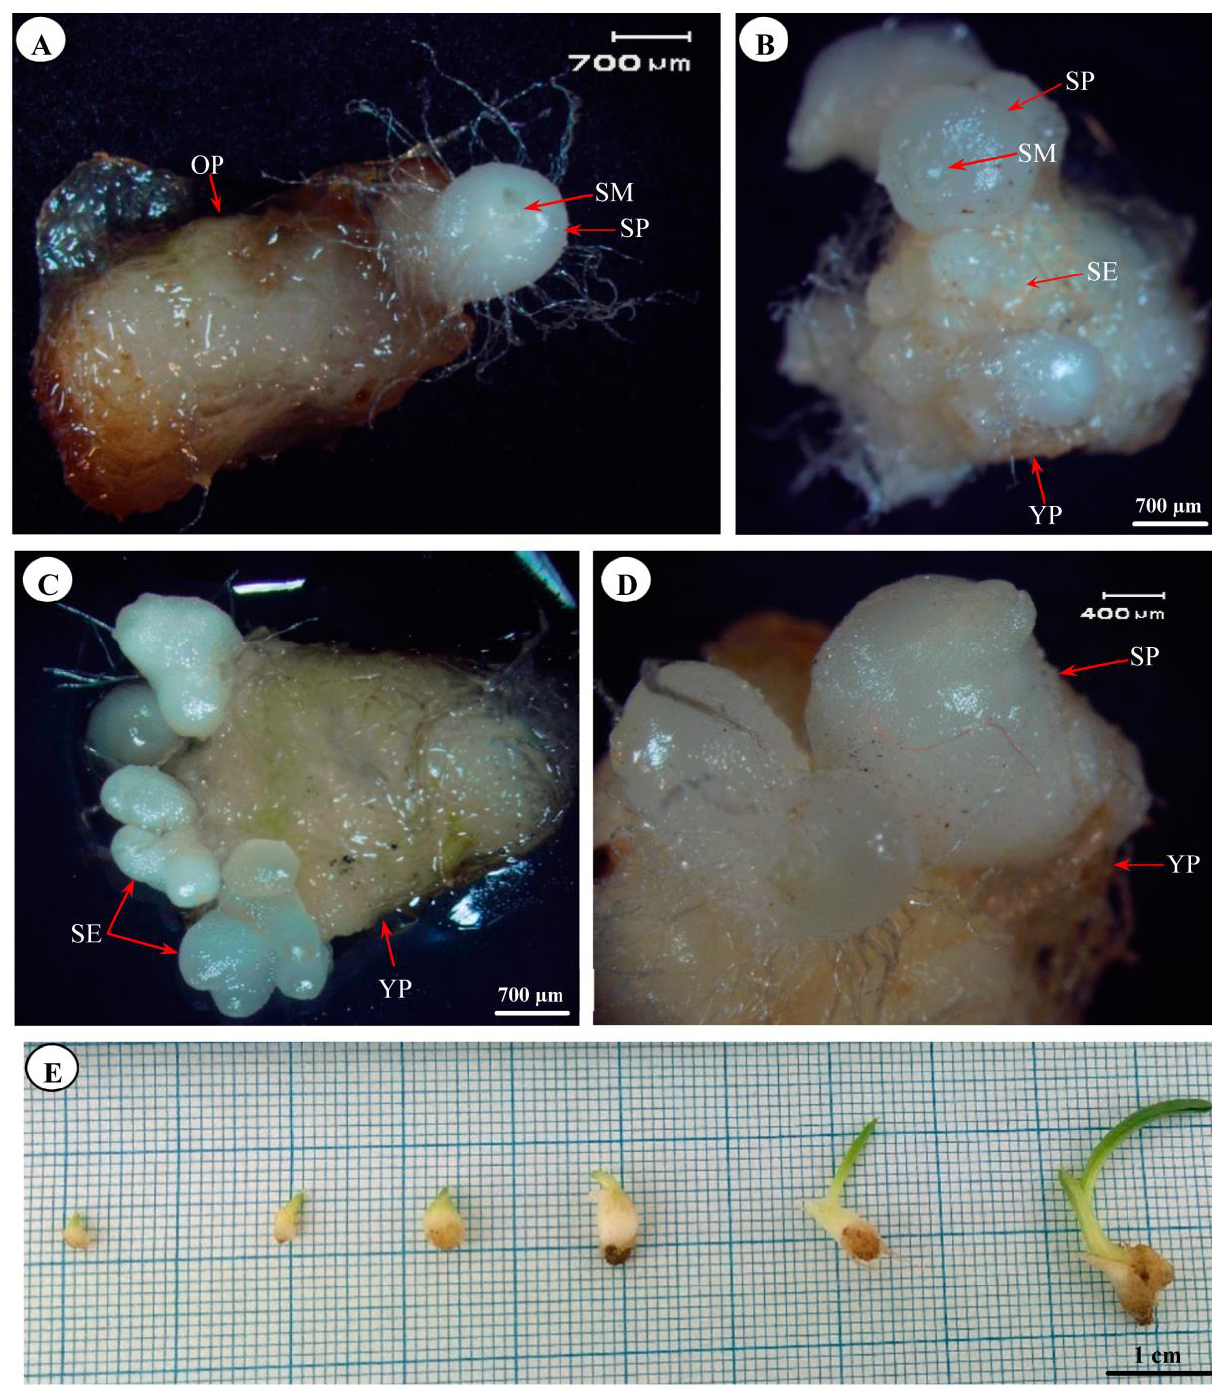
Figure 3. Embryogenesis and secondary protocorm-like body (PLB) formation in H. affine (Boiss.) Schltr. ( A ) The formation of secondary PLB with developed rhizoids on old protocorm as explant; ( A – D ) different stage of embryo development on PLB explants and turning to secondary PLB. ( E ) Different stage of plantlet development from secondary PLBs. OP, old PLB explant; SP, secondary PLB; SM, shoot meristem; YP, young PLB explant.